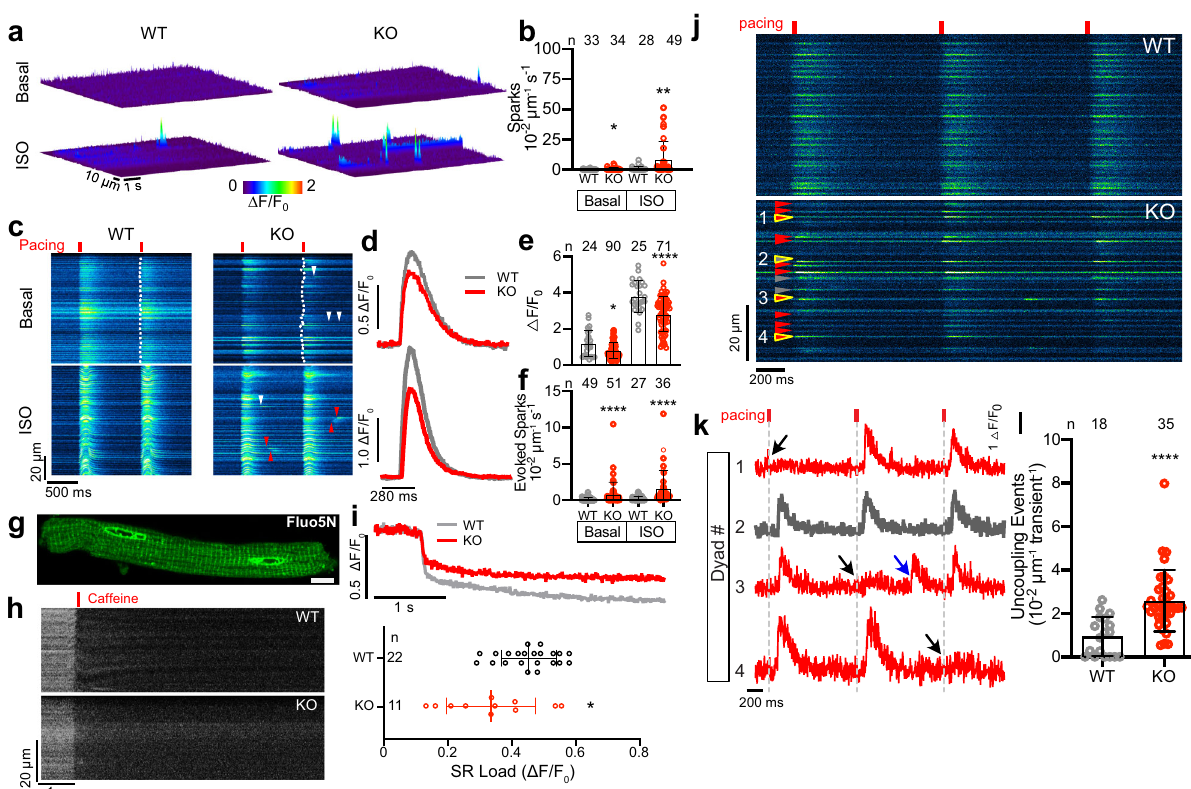
Fig. 4 Altered dyadic Ca 2 + release in CMYA5 KO cardiomyocytes. Ca 2 + release in mature Cmya5 KO or WT ventricular cardiomyocytes was assessed using a dyad-localized Ca 2 + nanosensor, GCaMP6f-Junctin (ASPH-G6f) and detected by confocal line scan imaging. a , b Surface plots of Ca 2 + sparks in basal and isoproterenol (ISO)-stimulated (100 nM) cardiomyocytes. Quanti fi cation is shown in (b). Mann-Whitney test within basal or ISO conditions. c – f Ca 2 + release during electrical pacing (red lines) under basal conditions or ISO stimulation. Dotted line, leading edge of the evoked Ca 2 + transient. Arrowheads, aberrant Ca 2 + release outside of the initial evoked Ca 2 + transient, without (white) or with (red) wave-like propagation. d. Representative Ca 2 + transients under basal (top) or ISO (bottom) conditions. e , f Quanti fi cation (mean ± SD) of Ca 2 + transient amplitude and Ca 2 + spark frequency. Mann-Whitney test within basal or ISO conditions. g – i Measurement of SR Ca 2 + stores using low-af fi nity Ca 2 + -sensitive dye Fluo5N and AAV-mediated expression of SR-targeted esterase, which trapped Fluo5N in SR. g, Fluo5N distribution. h , i SR Ca 2 + release induced by 10 mM caffeine. g – i